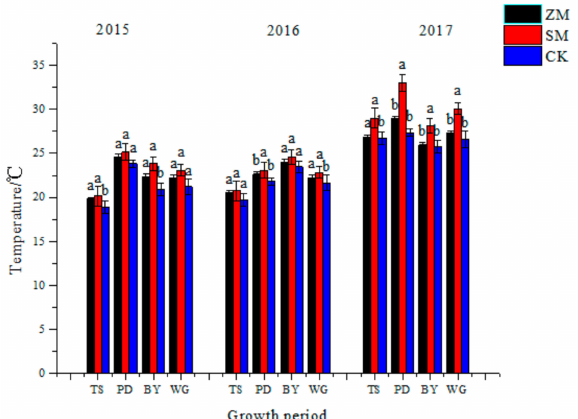
Figure 3. Changes of surface soil temperature under di ff erent treatments. Note: TS: Tillering stage; PD: Panicle developmental stage; BY: Blossom fruit period; WG: Whole growth period.